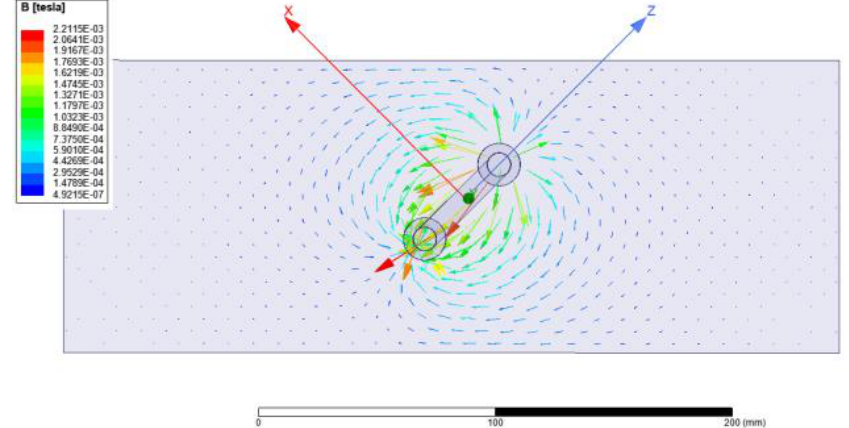
Figure 3. B-vector map of the sample.